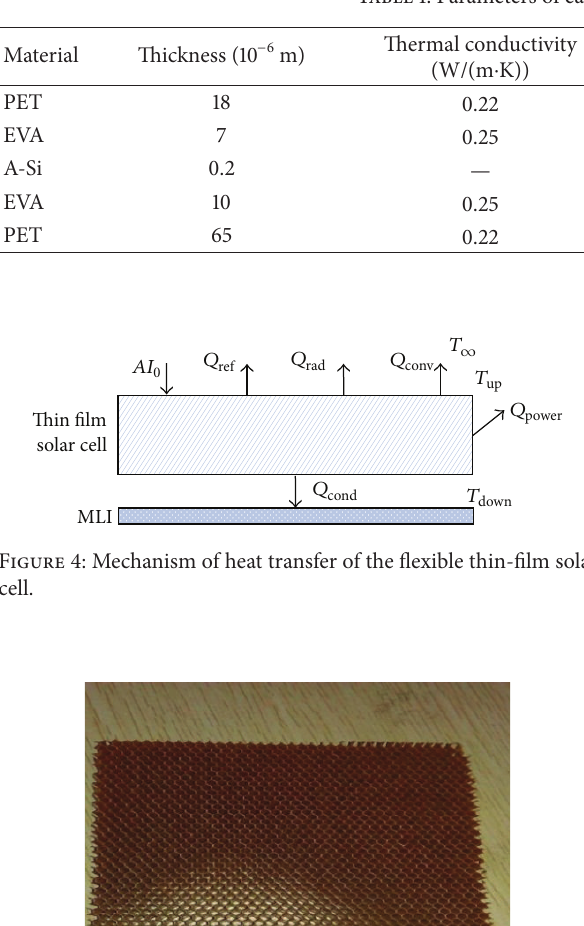
Table 1: Parameters of each layer of the thin-film solar cell.